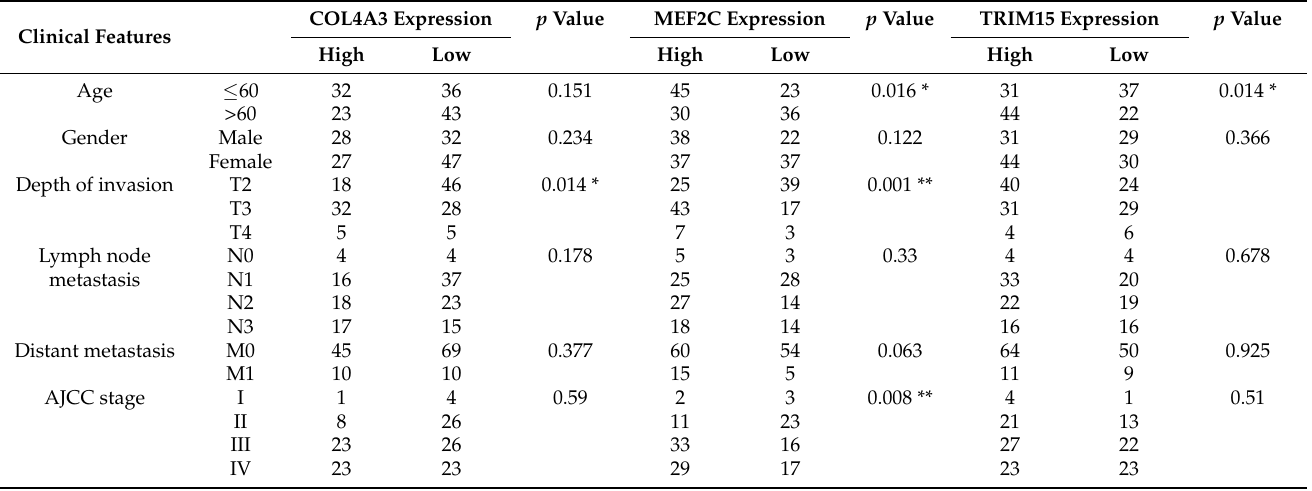
Table 2. Stratified analysis of COL4A3, MEF2C and TRIM15 for diffuse-type gastric cancer patients